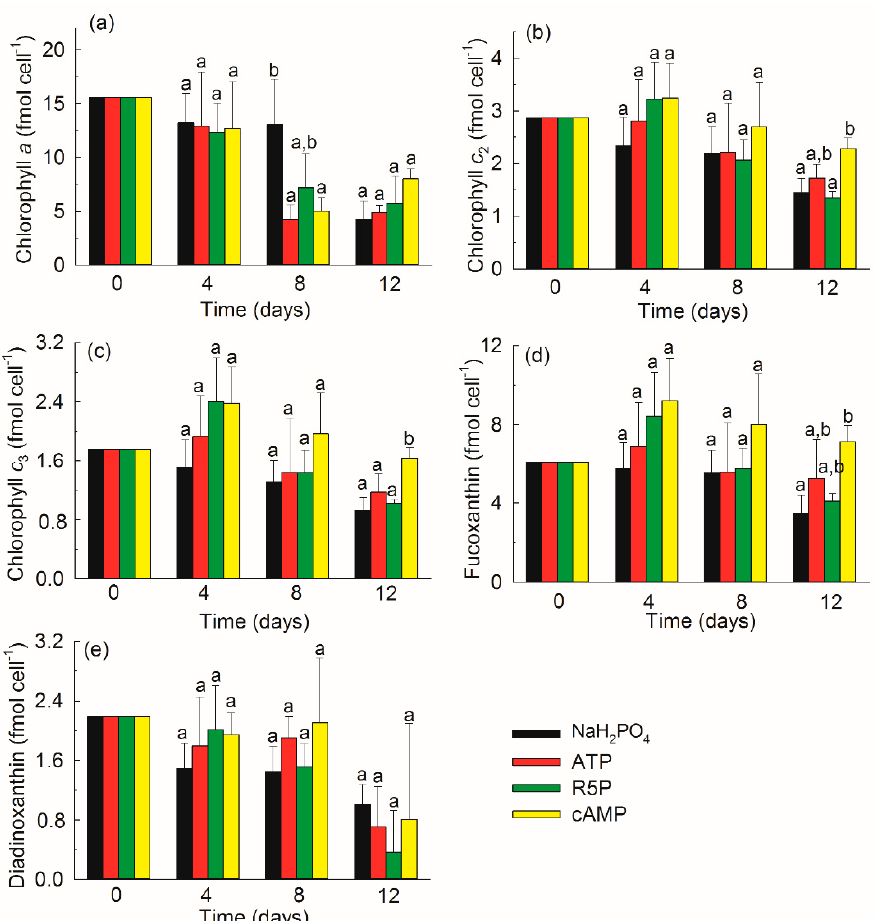
Figure 9. Contents of pigment chlorophyll a ( a ), chlorophyll c 2 ( b ), chlorophyll c 3 ( c ), fucoxanthin ( d ), and diatoxanthin ( e ) of Karenia mikimotoi in the NaH 2 PO 4 , adenosine triphosphate (ATP), ribulose 5-phosphate (R5P), and cyclic adenosine monophosphate (cAMP) treatments on days 0, 4, 8, and 12. The values are the mean ± S.D. ( n = 3). Significant differences ( p < 0.05) among different phosphorus substrates are shown with different lowercase letters.